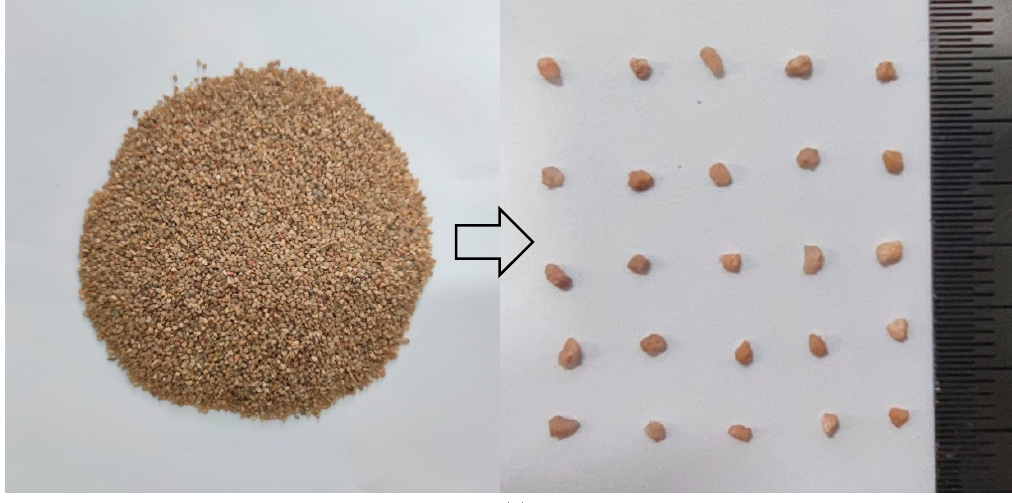
( b ) ( c ) Figure 3. Soil samples with three ranges of particle size: ( a ) 0.63–1.25 mm sand; ( b ) 1.25–2.50 mm sand; ( c ) 2.50–5.00 mm sand. Table 1. Basic physical properties of sand samples with different particle size ranges.